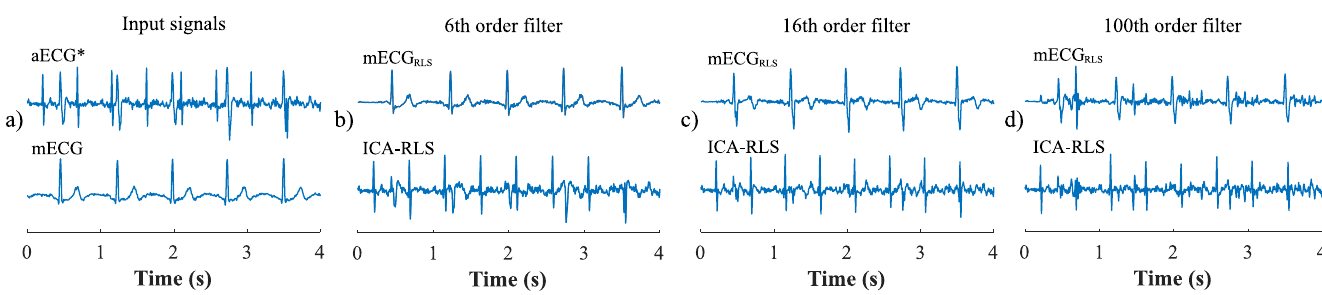
Fig 17. Influence of the filter order setting on the quality of the extracted fECG signal: a) aECG � and mECG signals used as the inputs to the RLS algorithm; b) low filter order settings, c) optimal filter order settings d) too high filter order settings.